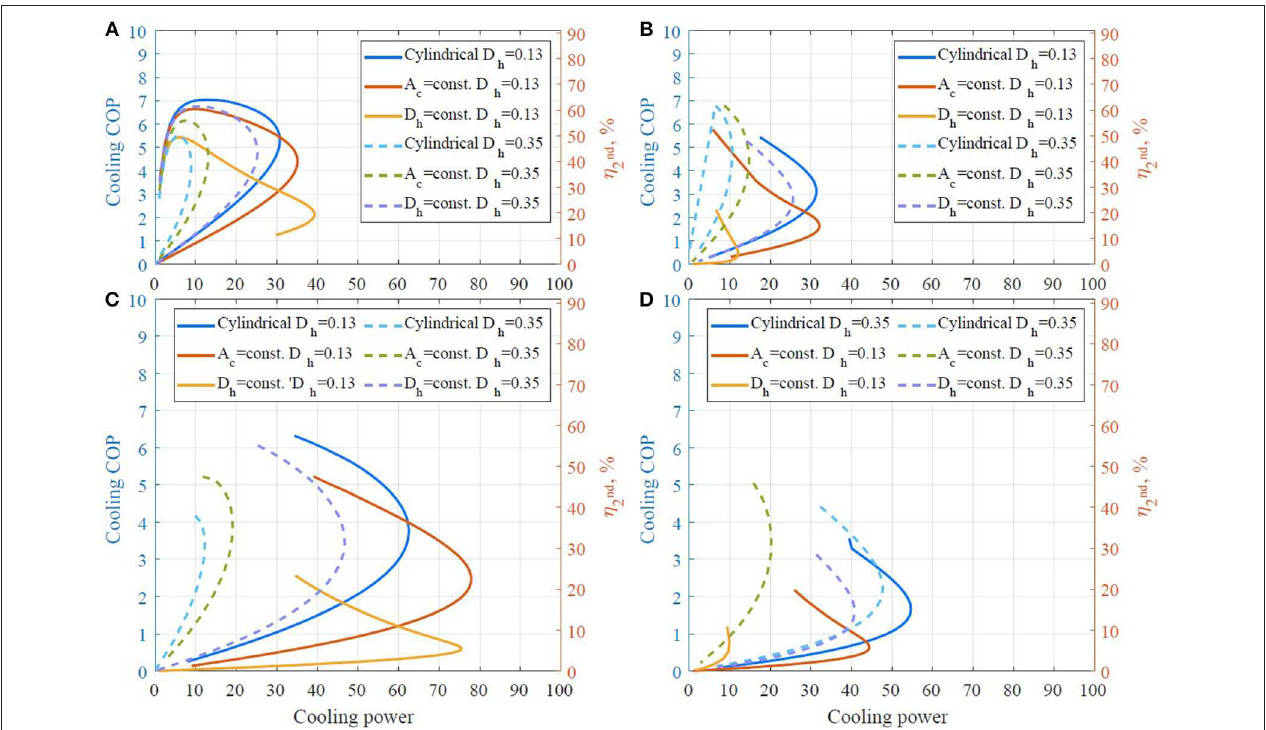
FIGURE 11 | Cooling COP as a function of cooling power at ε = 0.54. (A) Cassette 1, ν = 0.5Hz, (B) cassette 2, ν = 0.5Hz, (C) cassette 1, ν = 2Hz, (D) cassette 2, ν = 2